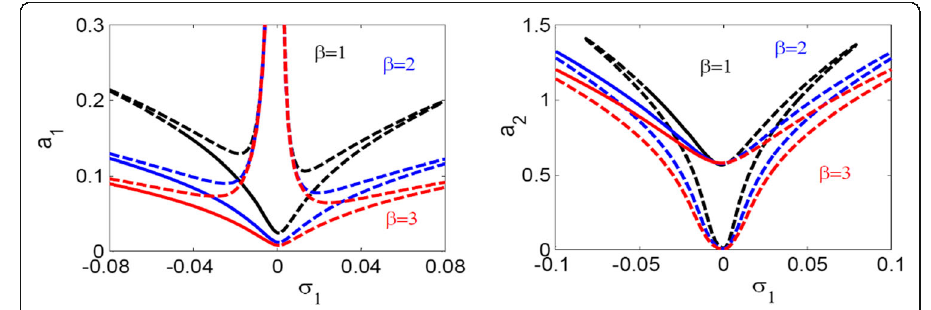
Fig. 6 Effects of feedback signal gain β